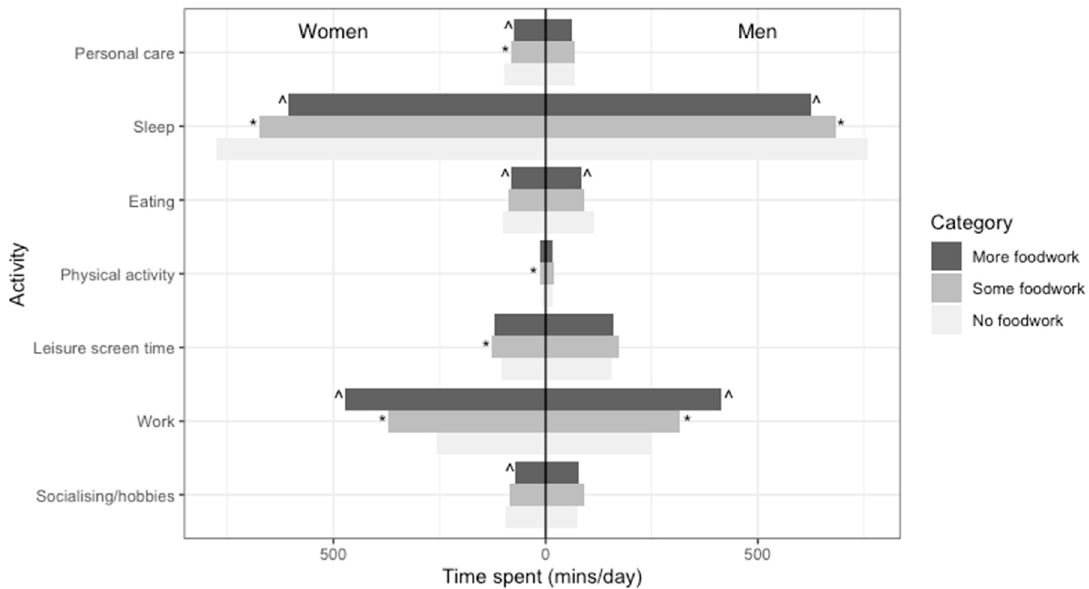
Figure 2. Model-adjusted a compositional means for men and women by foodwork category ( n = 6143) a Adjusted for age, gender, employment status, education, occupation, presence of children, and diary day type. ^ Statistically significant log-ratio difference between more and some foodwork for this part. * Statistically significant log-ratio difference between some and no foodwork for this part.